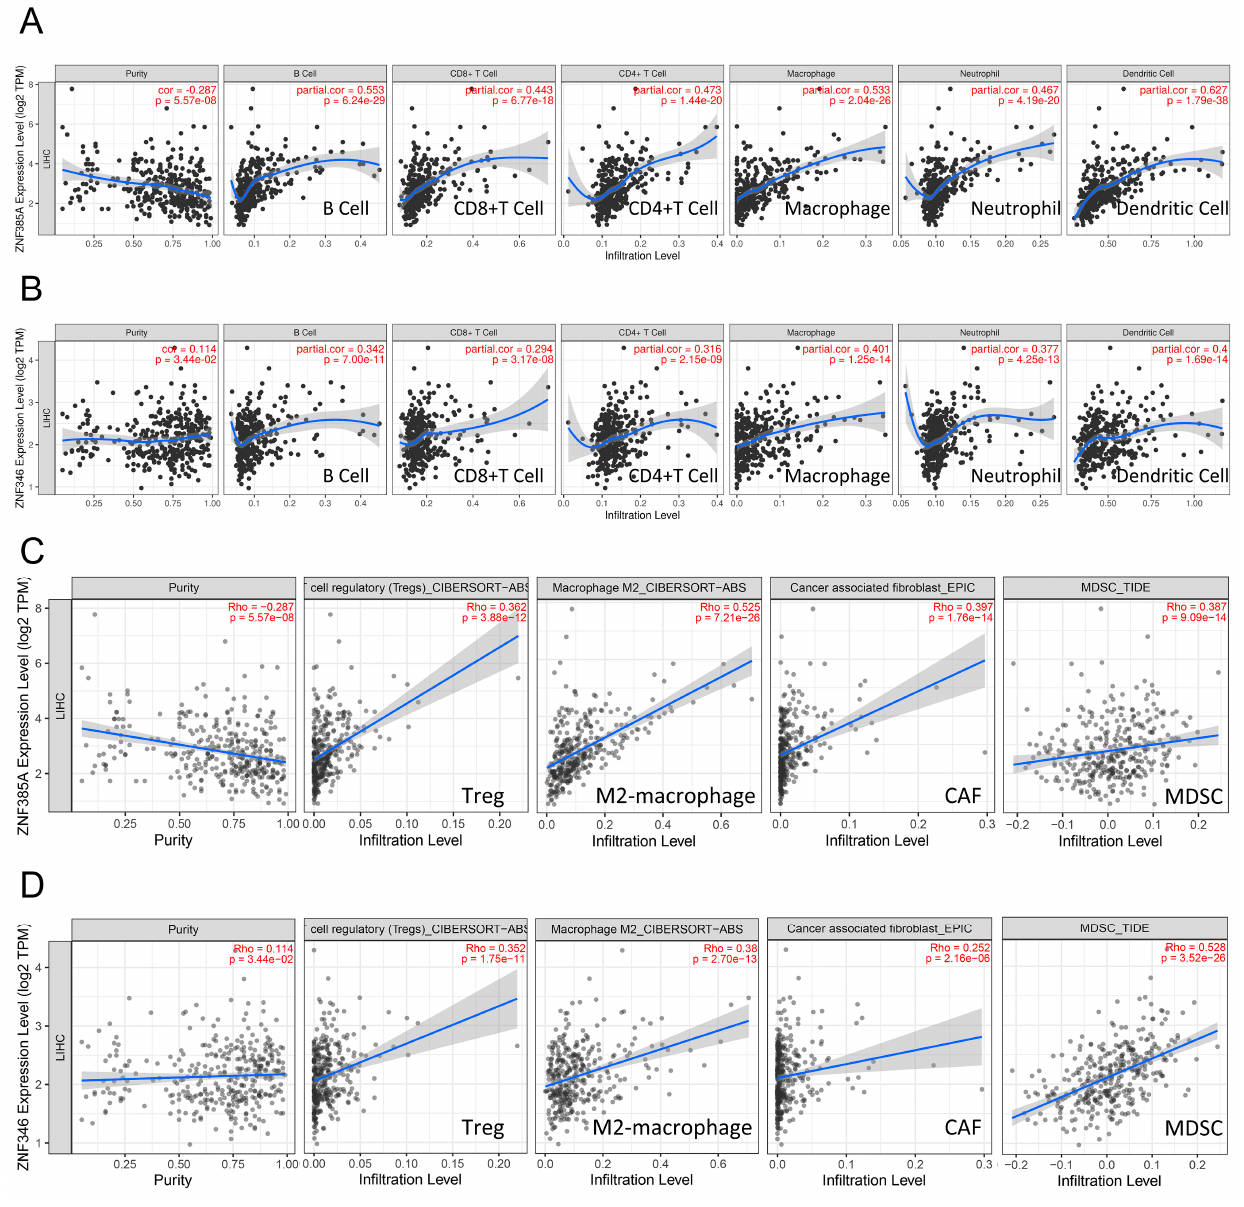
Figure 6. Correlation analyses between ZNF385A and ZNF346 expression, and the immune infiltration of multiple immune cells. ( A , B ) Correlation with six main infiltrating cells in HCC via TIMER. ( C , D ) Correlation with four immunosuppressive cells in HCC via TIMER2.